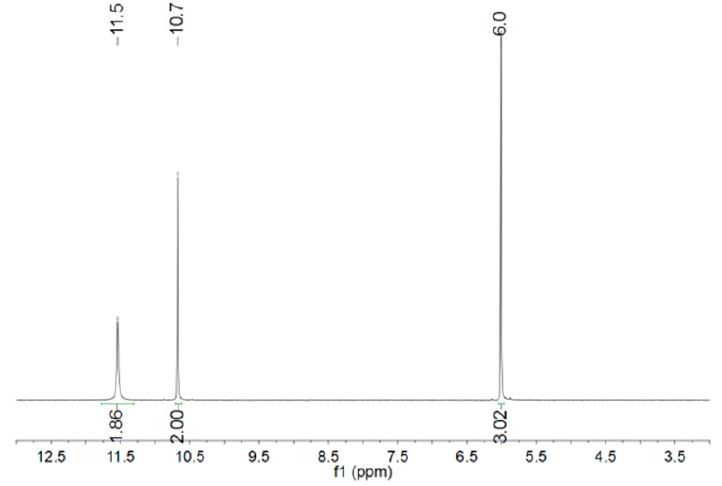
Figure 3. The 1 HNMR spectrogram (in DCl).